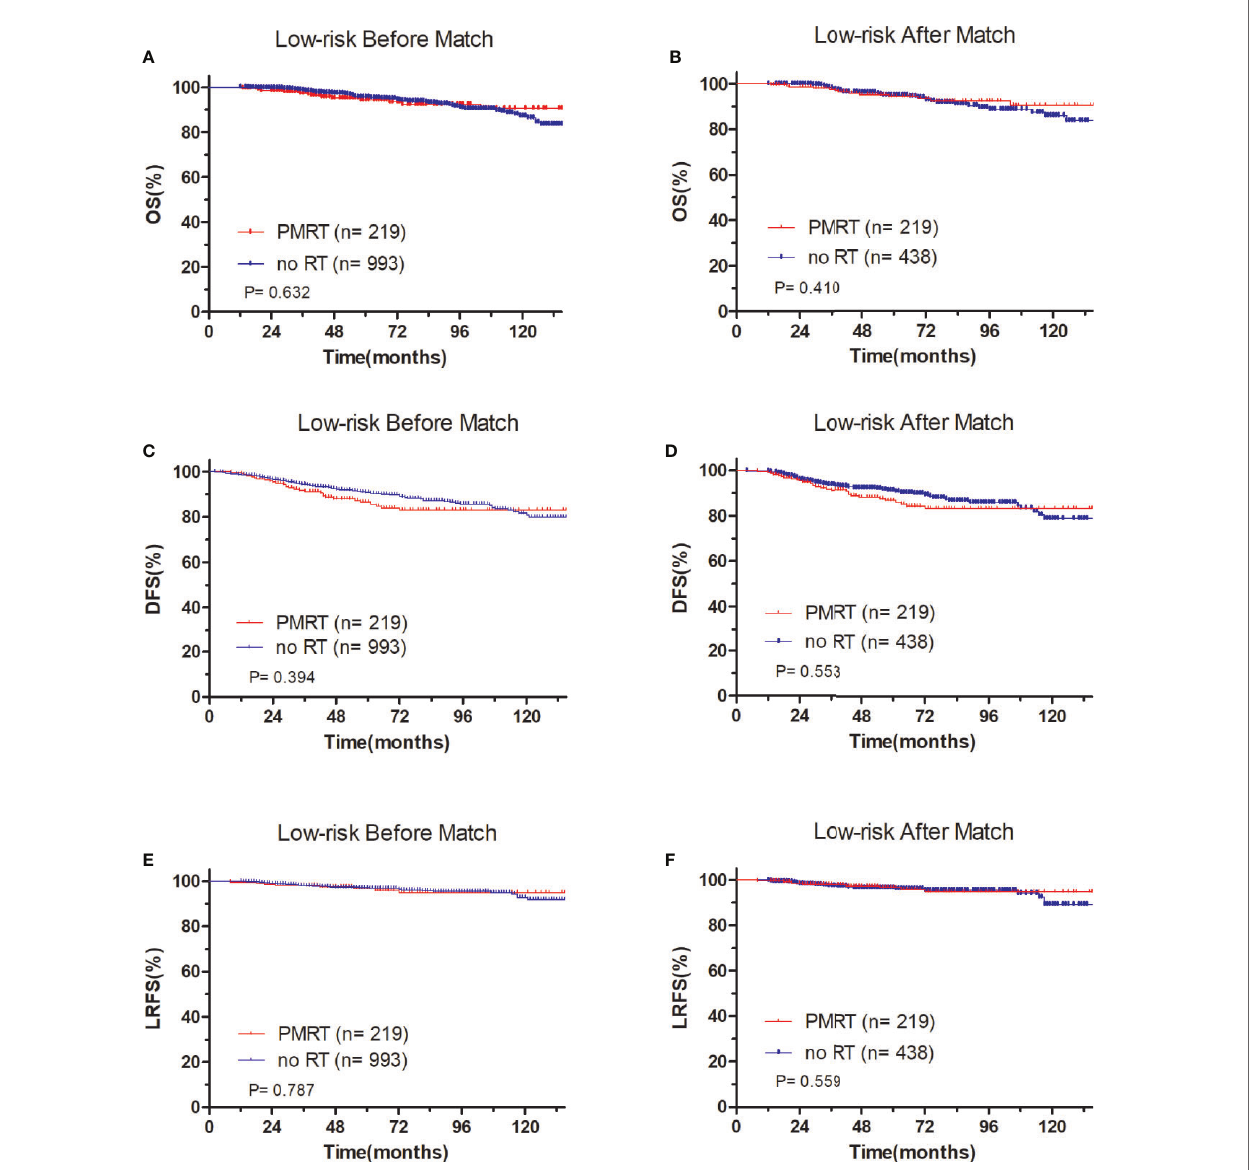
FIGURE 4 | Comparison of OS and DFS and LRFS between with PMRT and without PMRT for low-risk pT1-2N1M0 patients. For patients with PMRT or without PMRT, OS before (A) and after (B) match strati fi cation; DFS before (C) and after (D) match strati fi cation; LRFS before (E) and after (F) match strati fi